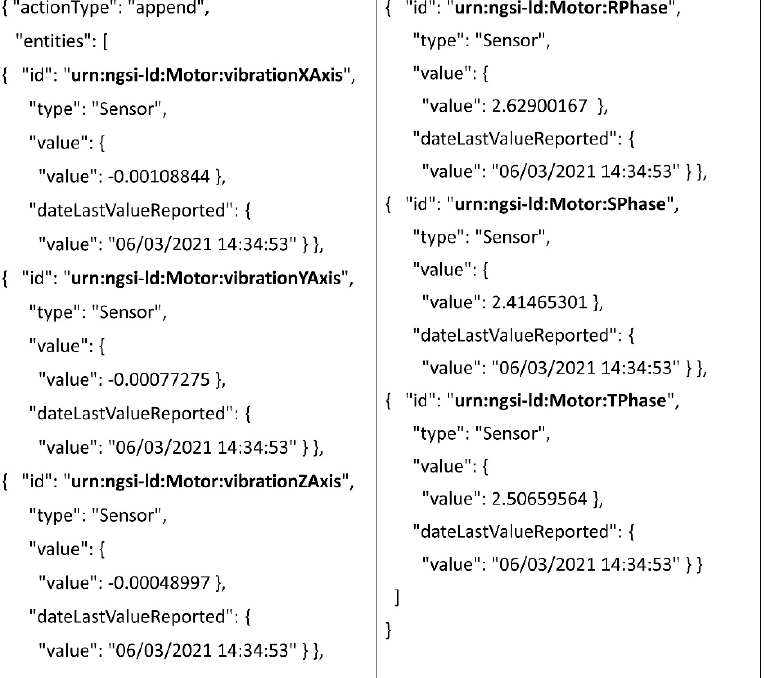
Figure 4. An example of a sensor data model implemented for monitoring electrical motor equip- ment.